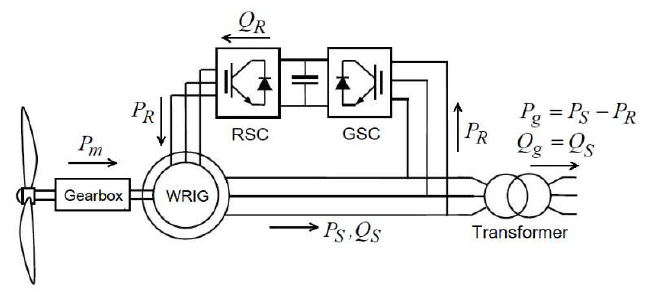
Figure 1. The basic structure of DFIG-based WPP.